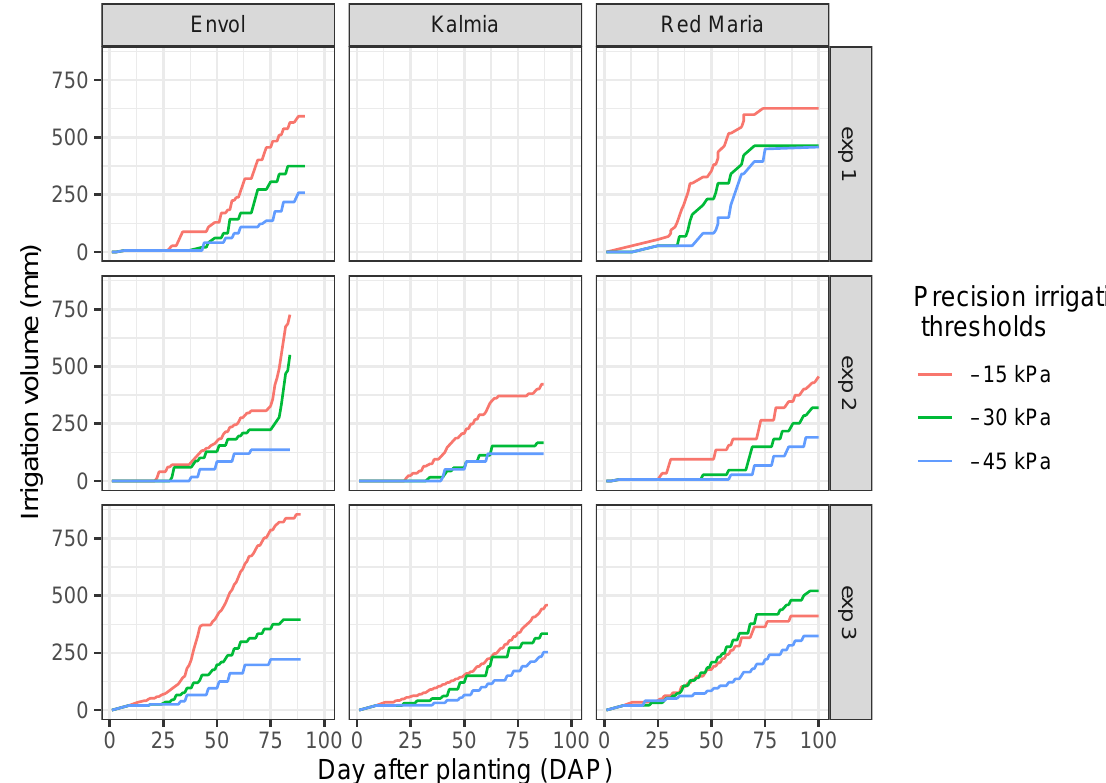
Figure 4. Cumulative irrigation volume for each variety, experiment and precision irrigation